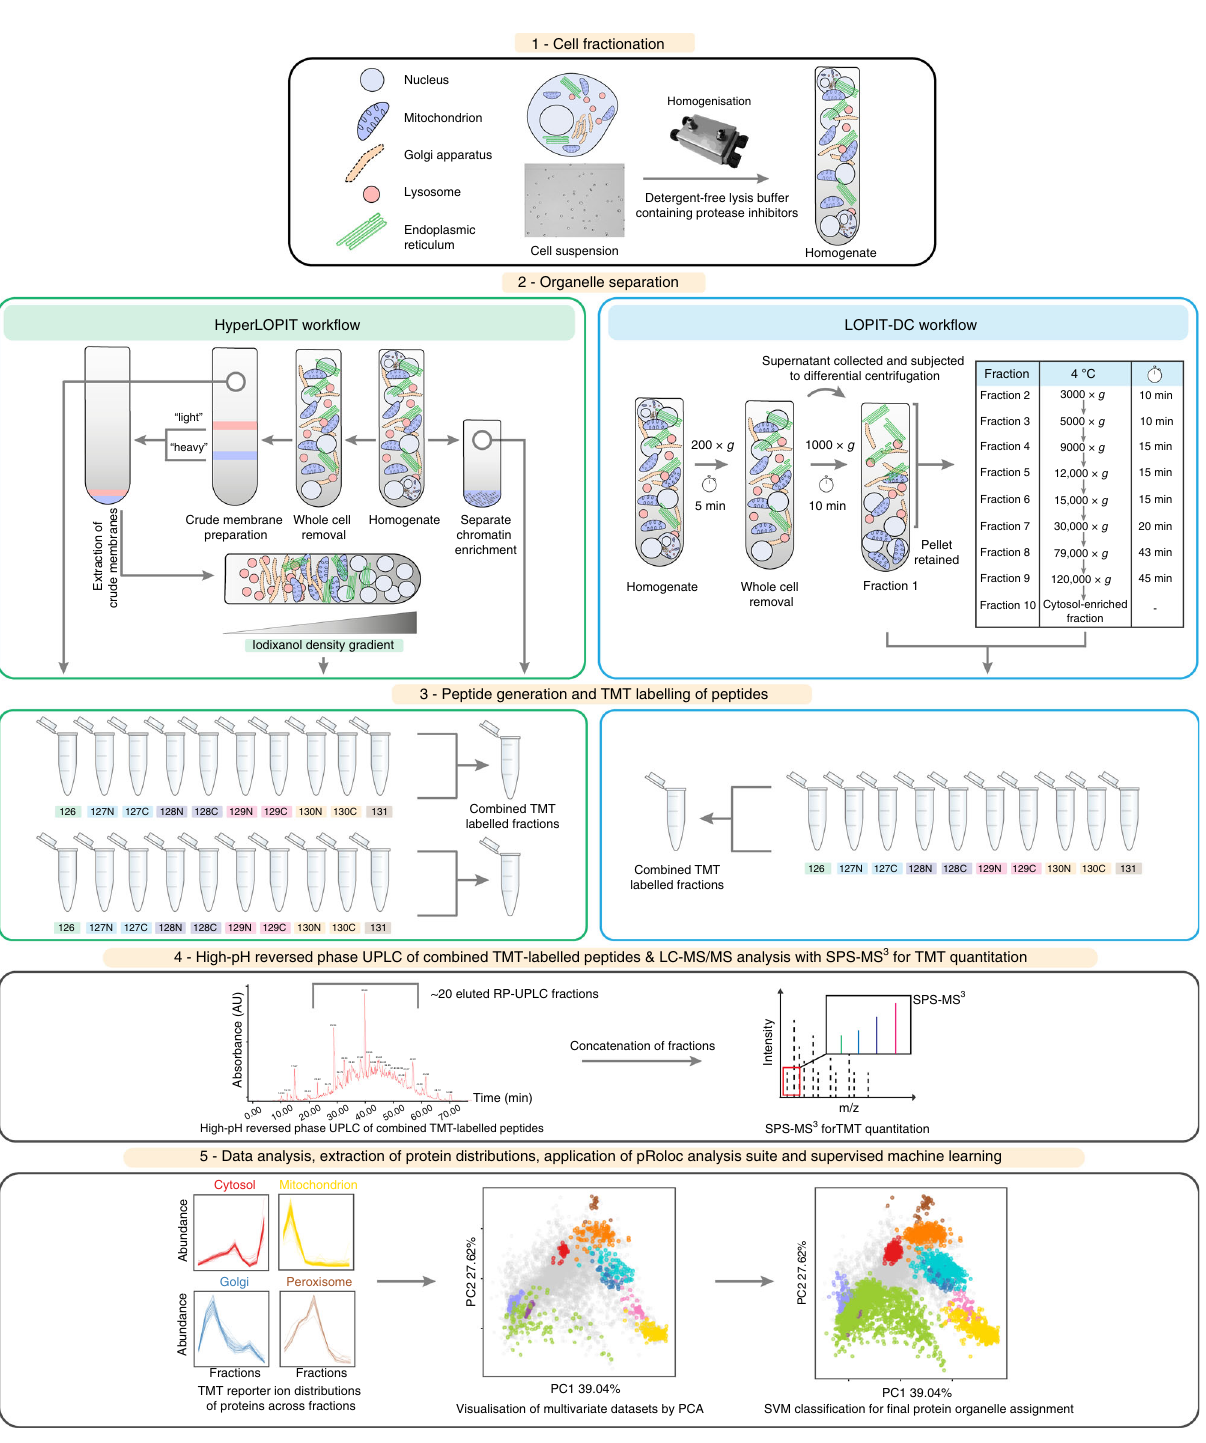
Fig. 1 Overview of the hyperLOPIT (left) and LOPIT-DC (right) work fl ows. LOPIT is a quantitative mass spectrometry-based method used for the separation of organelles and other subcellular compartments. The work fl ows differ in step 2 (organelle separation): hyperLOPIT is based on equilibrium density gradient ultracentrifugation from a crude membrane preparation, while LOPIT-DC utilises differential ultracentrifugation following removal of unlysed cells. In addition, hyperLOPIT includes a separate chromatin enrichment step. Both work fl ows take advantage of multiplex TMT-labelling (step 3) to reduce mass spectrometry analysis time and technical variability and SPS-MS 3 for accurate quanti fi cation (step 4). Data analysis for both work fl ows is performed using pRoloc (step As in hyperLOPIT, cell lysis in LOPIT-DC is followed by a whole cell-preclearing step necessary to remove unlysed cells that could confound downstream analysis. The cell lysis stage is critical in both methods, as insuf fi cient lysis can result in subcellular fractions with reduced protein yields while excessive lysis can